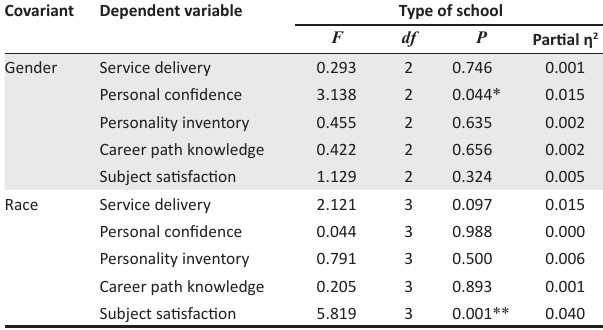
df , degrees of freedom. * , p ≤ 0.01.